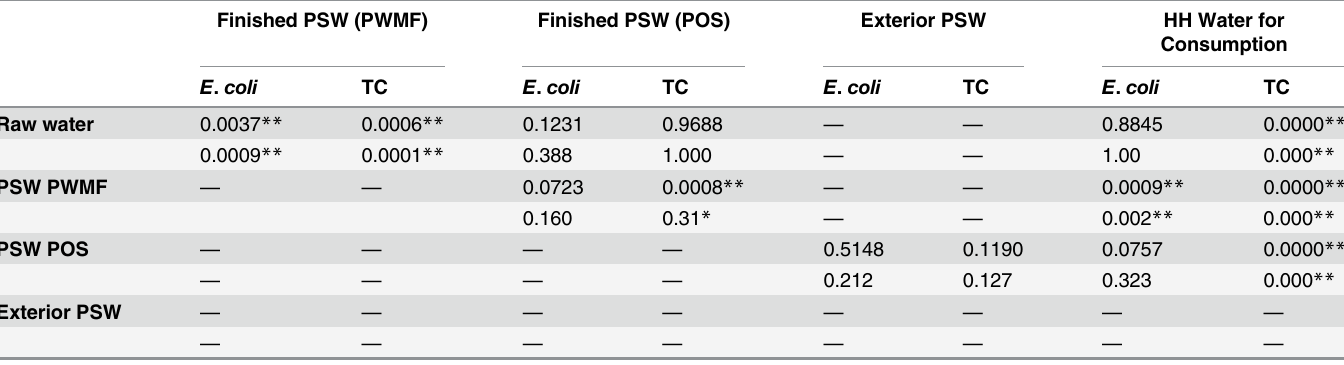
Table 2. P-values for Wilcoxon-Mann-Whitney tests (unpaired data) and Wilcoxon signed-ranks tests (paired data) comparing log concentrations of fecal indicator bacteria (FIB) in samples (first row) and hypothesis tests comparing proportions of positive samples (second row) (McNemar ’ s chi square test for paired data, and Fisher ’ s exact for unpaired data) for samples collected at different points in the supply